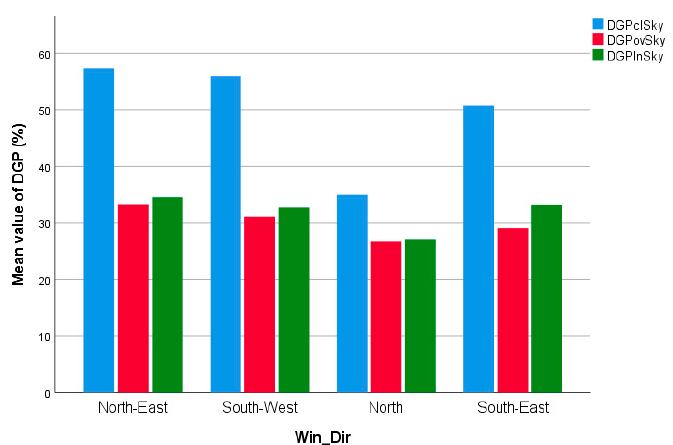
different sky conditions on 4 June at 10 a.m.